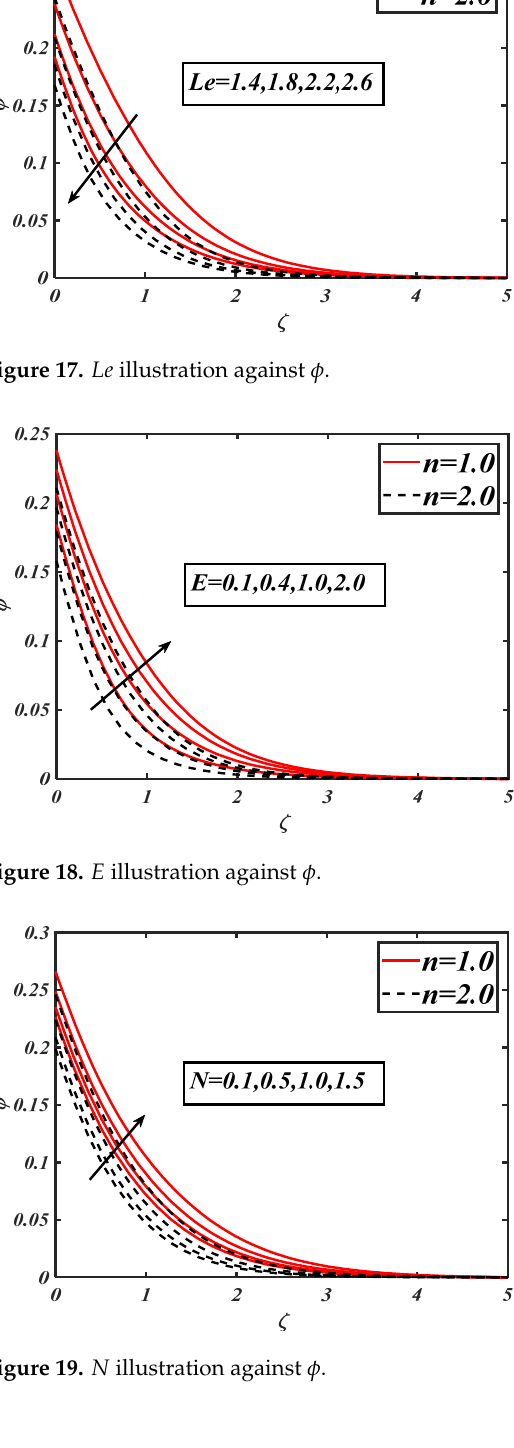
Figure 19. N illustration against φ